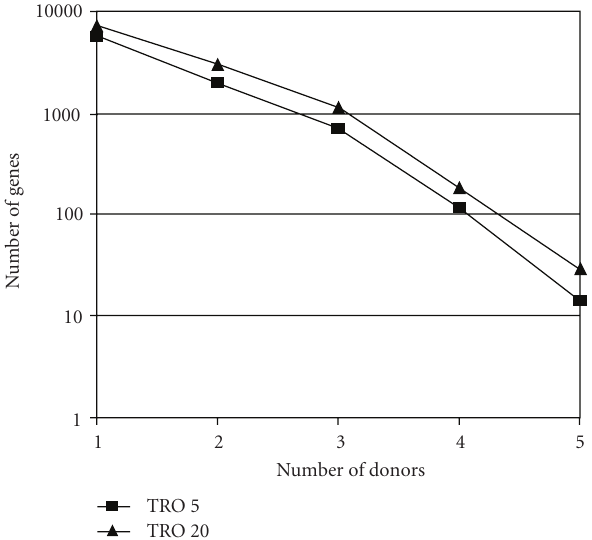
Figure 2: Total gene numbers modulated by 5 and 20 μ M TRO in primary human hepatocytes from one to five donors (FC ≥ 1 . 5pv ≤ 0 . 01). Cultures and microarray analysis as in Table